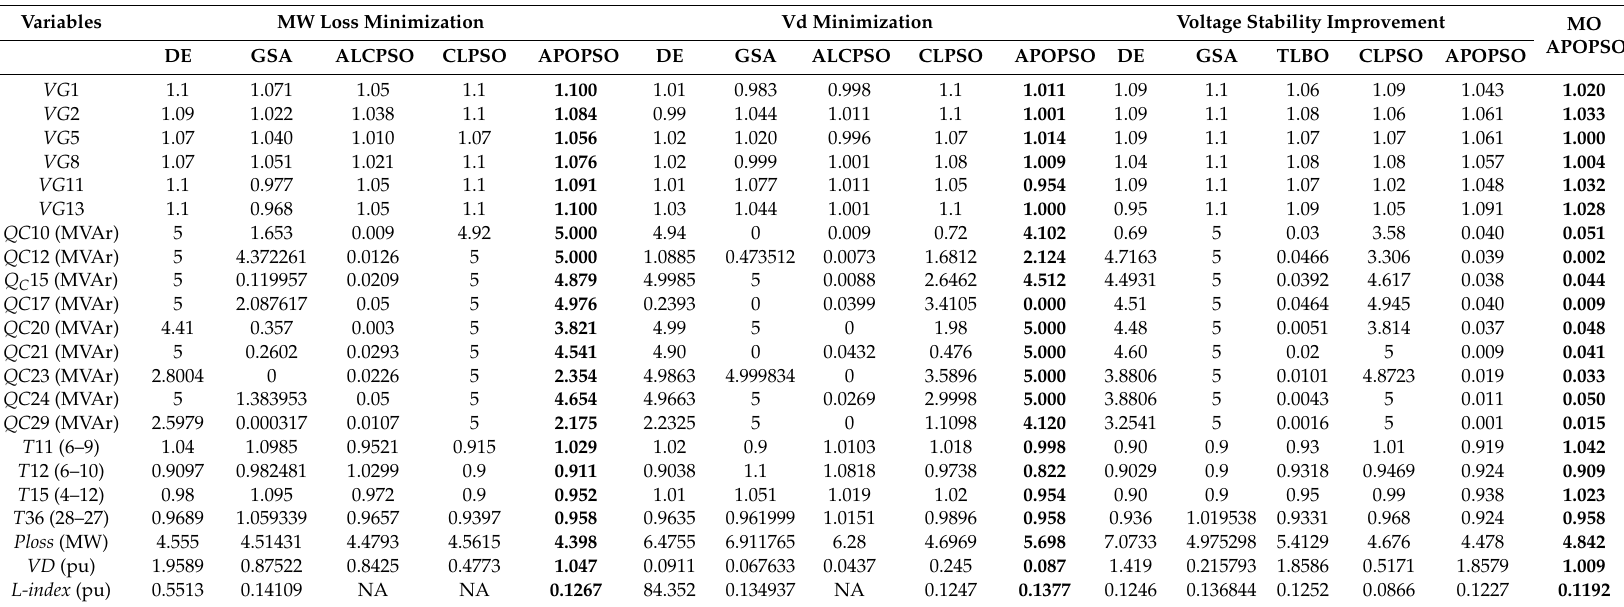
Table 3. Comparison with di ff erent metaheuristic algorithms reported in the literature for the IEEE 30 bus